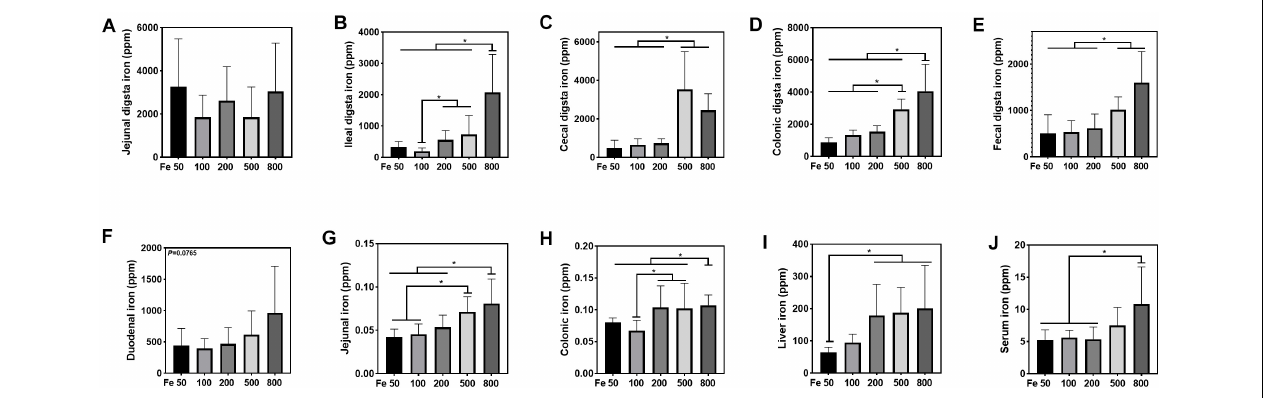
FIGURE 2 | Dietary iron increased iron deposition in intestinal digesta, intestine, liver, and serum. The iron concentration in the jejunal digesta (A) was similar among different groups. Iron levels of ileal (B) , cecal (C) , and colonic digesta (D) and feces (E) in the Fe800 group were significantly higher than those in the Fe50, Fe100, and Fe200 groups, and iron abundance of cecal and colonic digesta and feces in the Fe500 group was also higher compared with that in the Fe50, Fe100, and Fe200 group. Tissue iron content in the duodenum (F) , jejunum (G) , colon (H) , liver (I) , and serum (J) went up from Fe50 to Fe800. Ordinary one-way ANOVA or Kruskal–Wallis test was used for the statistical analysis among different groups. Data were presented as mean ± SD. * P <